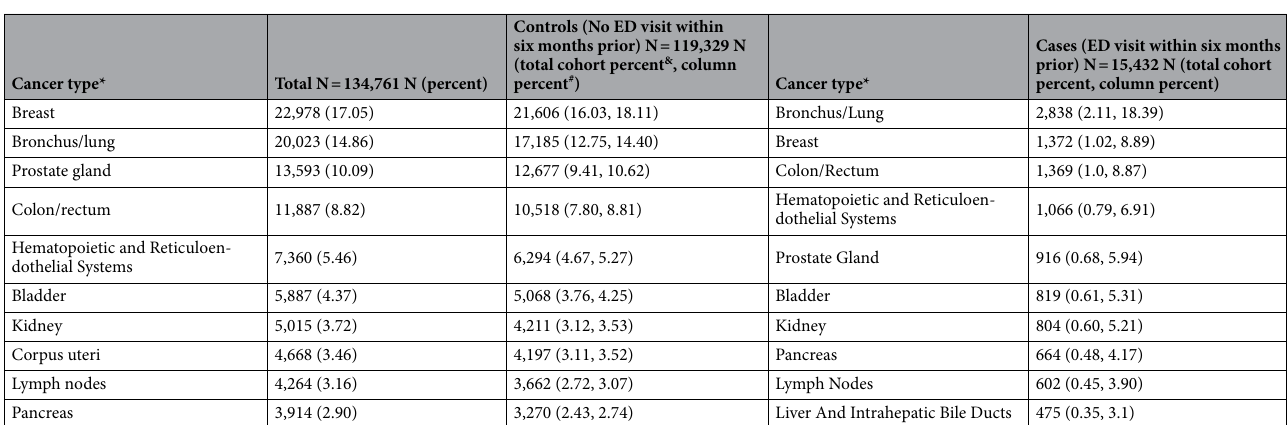
Table 2. Frequency of cancers among controls and cases. *Displaying top 10. & total cohort percent is the column value divided by the N total (137,761), # column percent is the column value divided by the column’s total